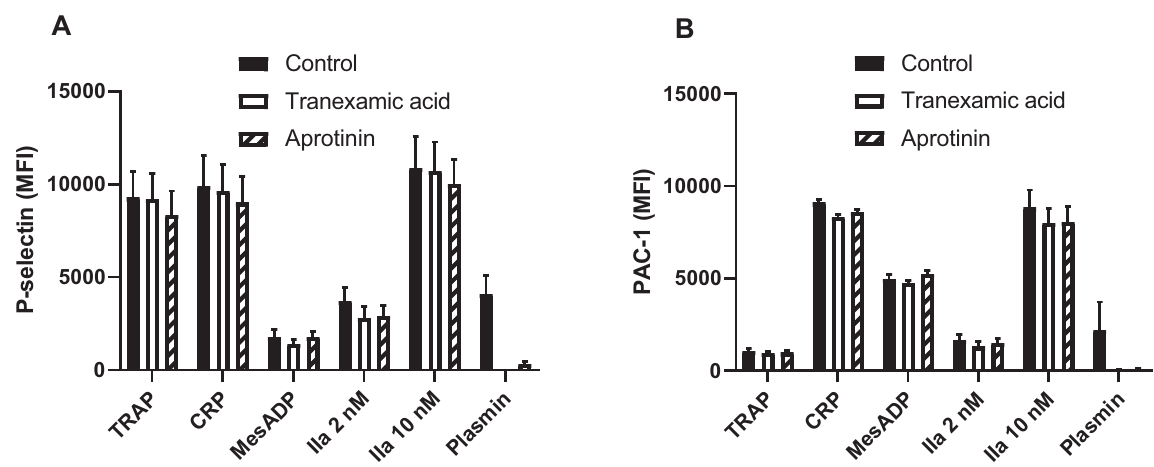
Fig. 10 Effects of aprotinin and TXA on platelet activation by thrombin receptor activating peptide (TRAP), collagen-related peptide (CRP),2MeS-ADP, thrombin (IIa), and plasmin. Diluted whole blood was stimulated with one of the mentioned agonists or vehicle, and P-selectin expression (panel A) or activation of α IIb β 3 (panel B) were assessed by fl ow cytometry using anti-P-selectin or the PAC-1 antibody. Shown are median fl uorescence intensity (MFI) corrected for values obtained in unstimulated samples. Bars indicate means of three independent experiments each performed in triplicate, error bars indicate standard